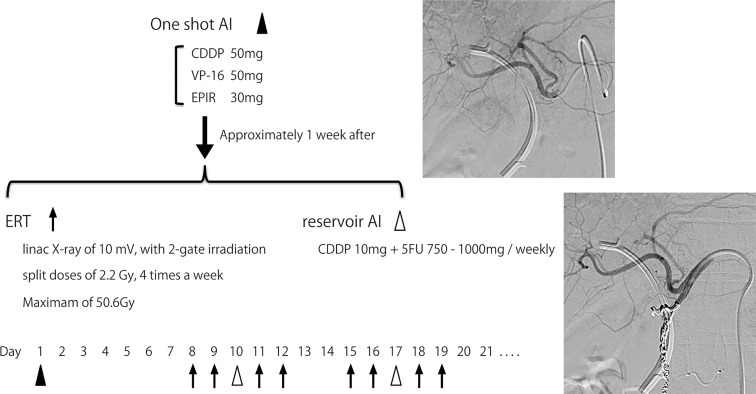
Process of AI+RT combination therapy. One-shot AI consisted of cisplatin 50 mg, etoposide 50 mg and epirubicin 30 mg (EEP therapy). Approximately 1 week after one-shot AI, external beam radiation therapy (ERT) was started. ERT used linac X-ray of 10 mV, with 2-gate irradiation administered to the target as split doses of 2.2 Gy, 4 times a week, with a maximum of 50.6 Gy. The irradiation field includes from the pancreas head to the liver duodenum ligament, focusing on the primary tumor. The reservoir system of AI was embedded in the subcutaneous of the groin area almost at the same time as ERT was started. A catheter was placed by the gastroduodenal artery (GDA) coil method, and the side hole was positioned near the common hepatic artery. AI from the reservoir (reservoir AI) was performed with FP therapy (5FU 750-1,000 mg + cisplatin 10 mg) once a week.